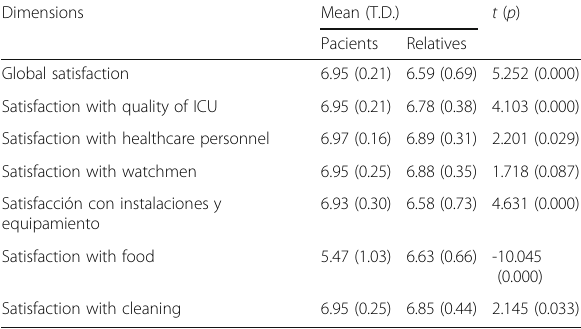
Table 1 (abstract 000865). Differences in pacients and relatives ’ satisfaction in the